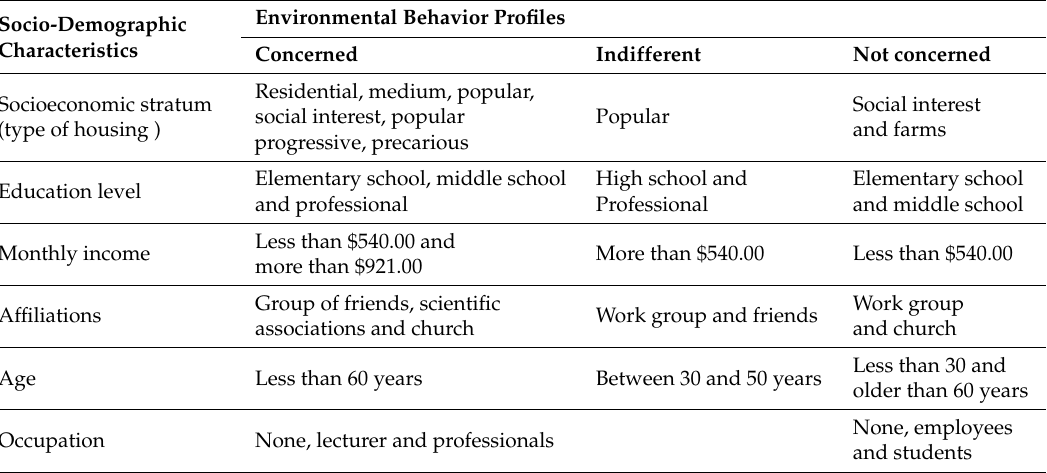
Table 10. Socio-demographic variables associated at environmental behavior